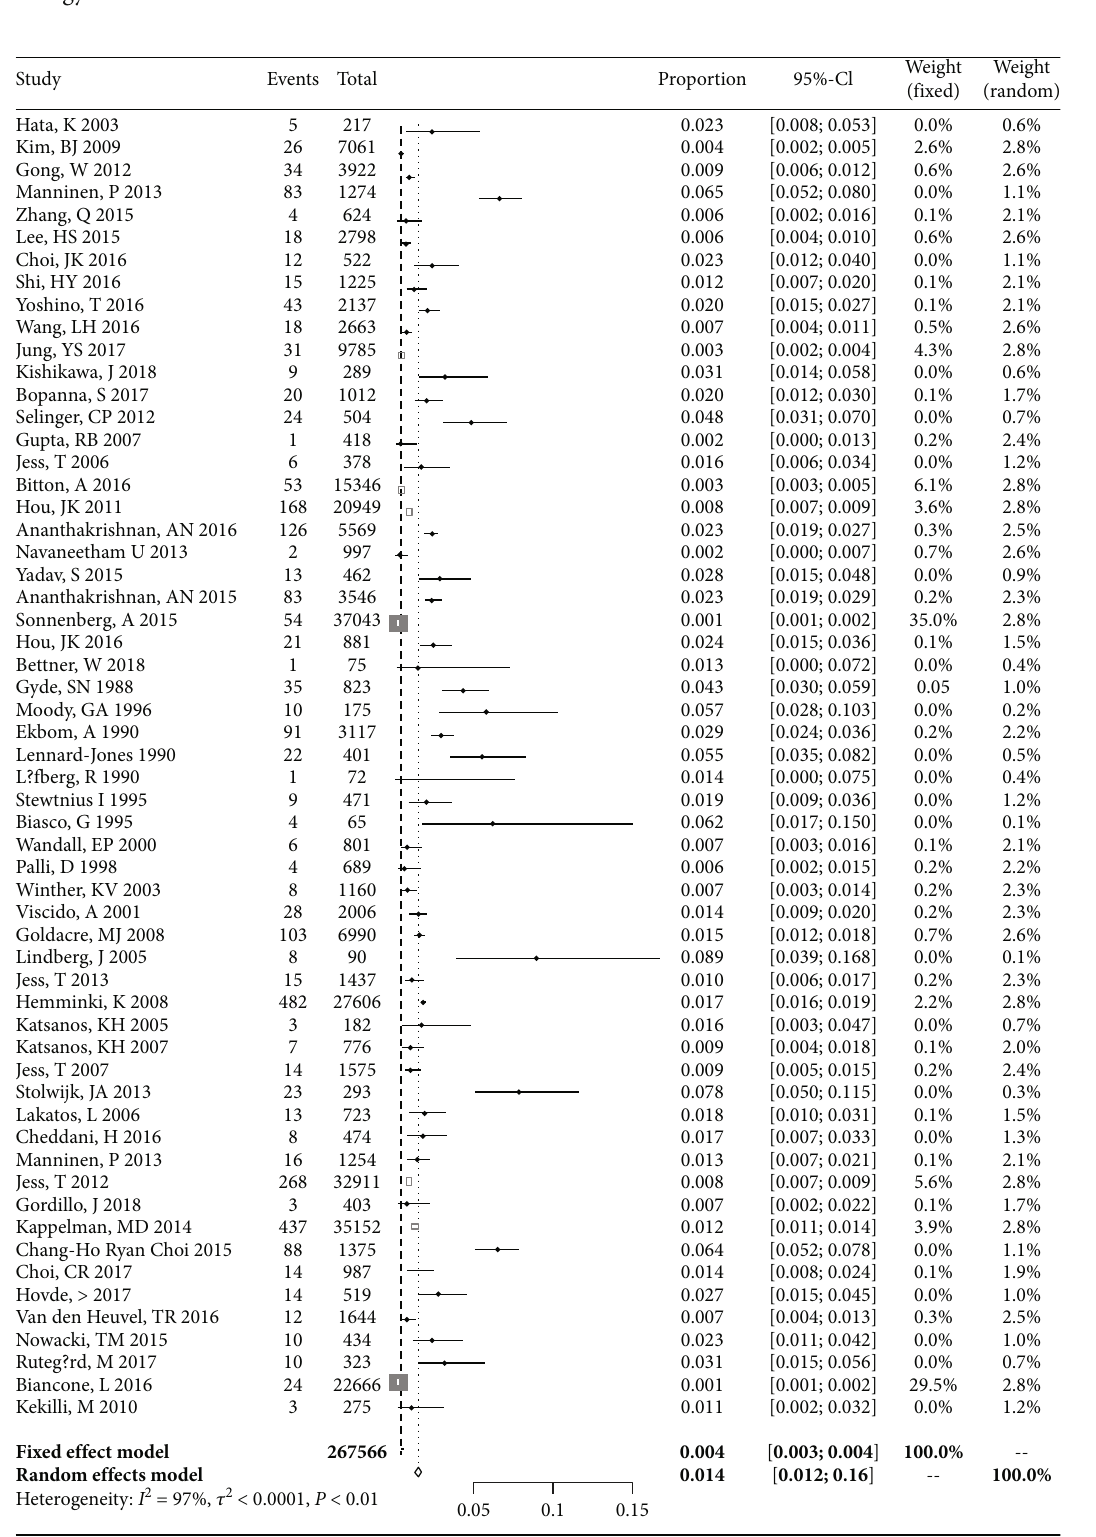
Fixed effect model Random effects model